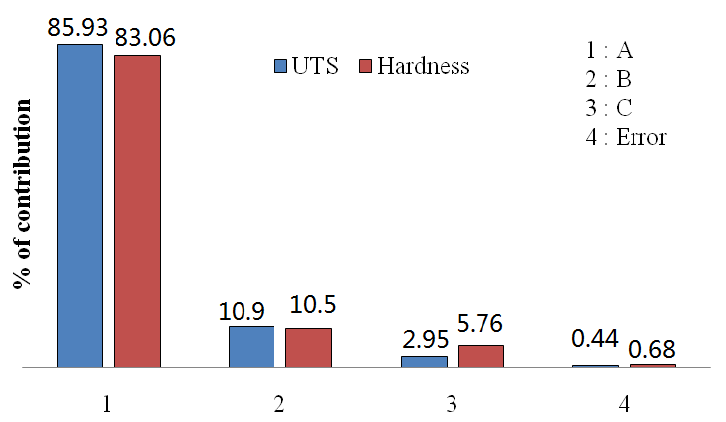
Figure 3. Percentage contribution of significant control